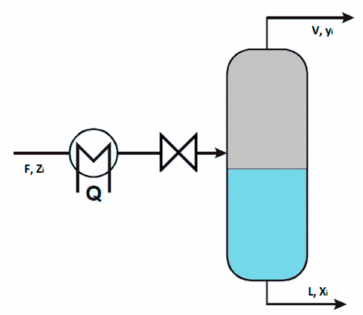
Figure 1. Phase-splitting at constant temperature and pressure